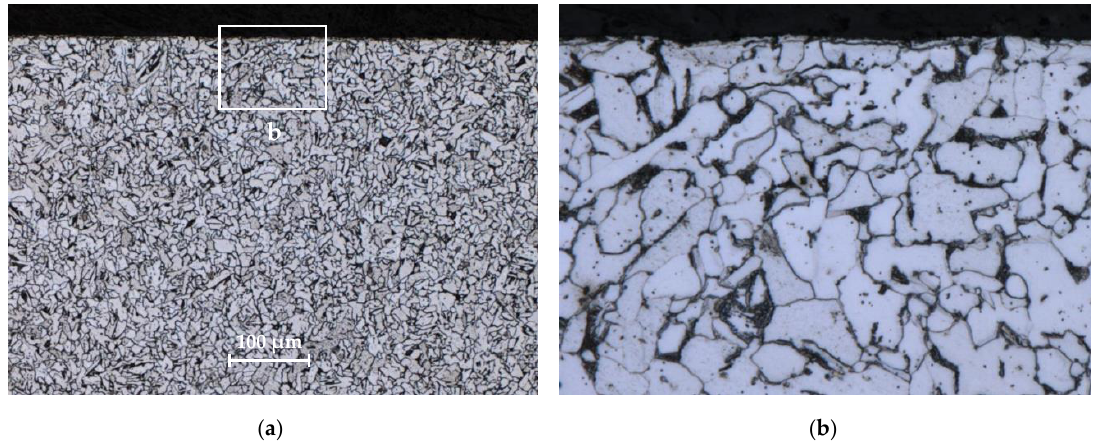
Figure 3. Microstructure of S235JR steel: ( a ) general view; ( b ) enlarged marked area.